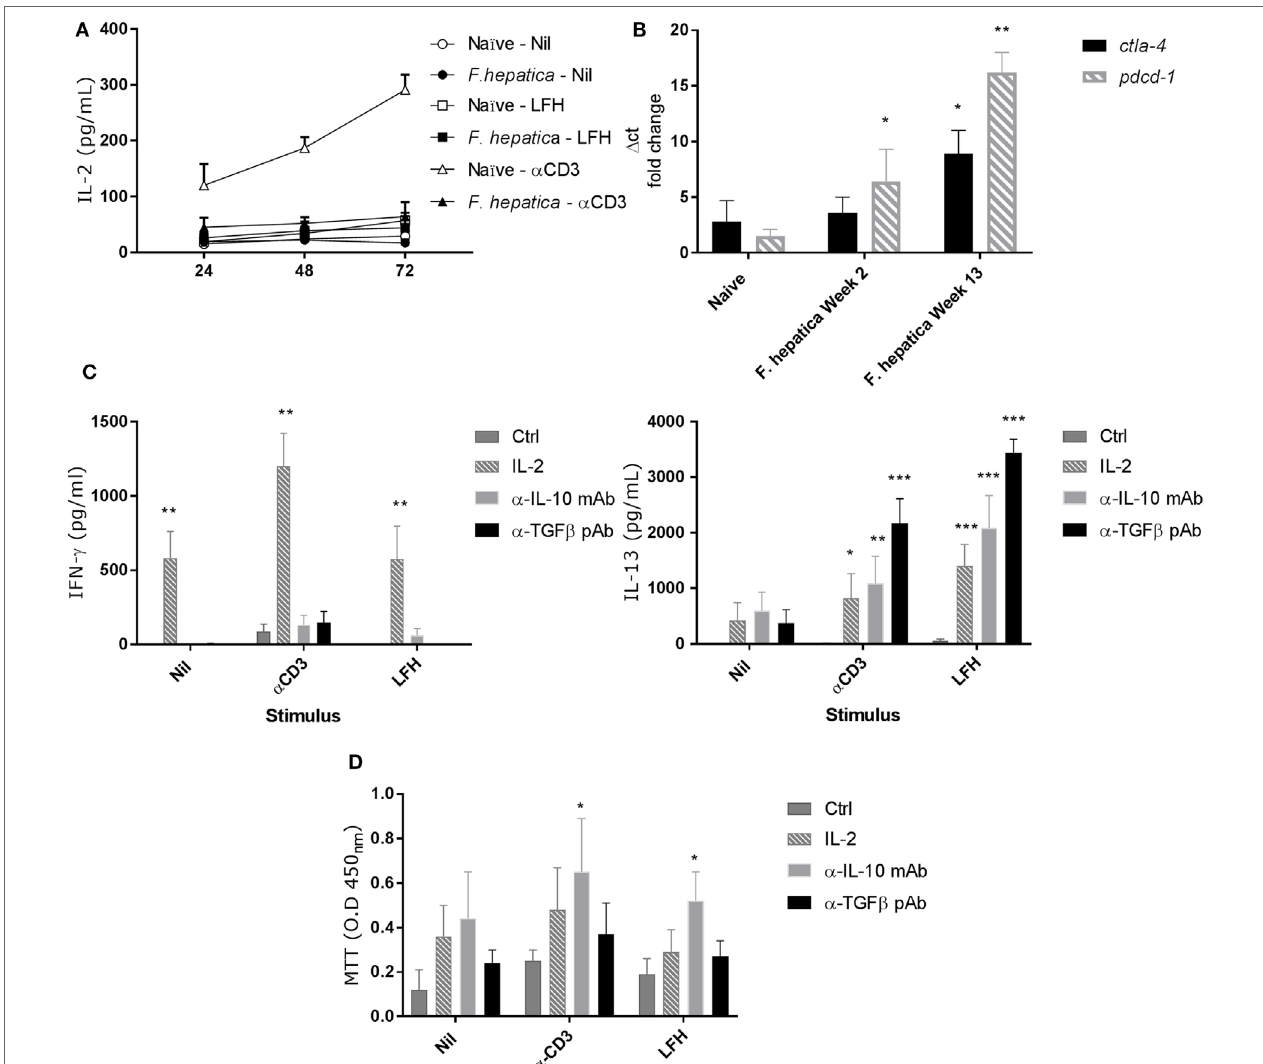
FigUre 4 | Failure to produce IL-2 and markers of anergy are coincident with non-responsive CD4 T-cells. (a) CD4 T-cells were isolated from the hepatic lymph node (HLN) of naïve or infected animals and cultured with α -CD3, LFH, or PBS (nil) for 72 h. Supernatants were recovered at every 24 h and tested for IL-2. There is a clear failure of CD4 T-cells from the HLNs of infected animals to secrete IL-2. However, naïve CD4 T-cells readily secrete IL-2 over time with a near linear accumulation of cytokine. (B) mRNA from CD4 T-cells was isolated, cDNA prepared, and qPCR carried out. There is a clear increase in pdcd1 expression from week 2 onward when compared to naïve animals. Ctla4 expression is significantly upregulated at week 13 but not week 2. (c) The effect of exogenous IL-2, or neutralizing IL-10 or TGF- β antibody on the expression of IFN- γ (left) and IL-13 (right) in infected CD4 T-cells from HLN was examined. There was a clear impact of IL-2 on IFN- γ , and IL-13 production was restored in the presence of all three treatments but to varying degrees. Ctrl represents cells treated with isotype Ab only at equal concentrations to neutralizing Ab. (D) CD4 T-cell proliferative responses in the HLN were assessed using the MTT dye assay after stimulation in the presence of treatments as in (c) . LFH and α -CD3 responsiveness was restored in the presence of α -IL-10 when compared within stimulation to non-treated controls. Bars represent the mean of seven animals ± SEM. Significant differences were determined using Friedman test with a post hoc comparison using a Wilcoxon ranked-sign test (a,c,D) and Kruskal–Wallis with Dunn’s multiple comparisons (B) where * P < 0.05, ** P < 0.01, *** P <